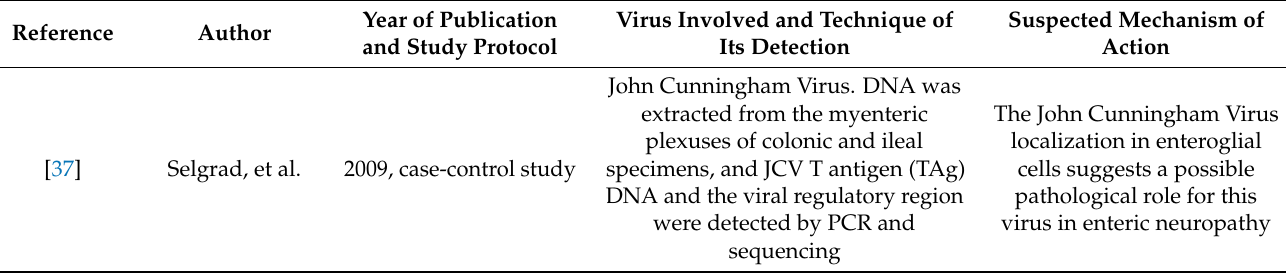
Table 1. Summary of the evidence regarding the interlacing between chronic idiopatic intestinal pseudo-obstruction and viral